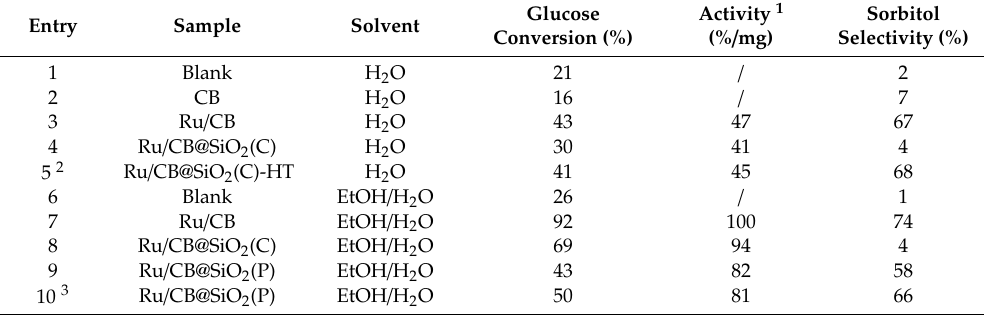
Table 2. Conversion and selectivity for the hydrogenation of glucose after 2 h reaction at 150 ◦